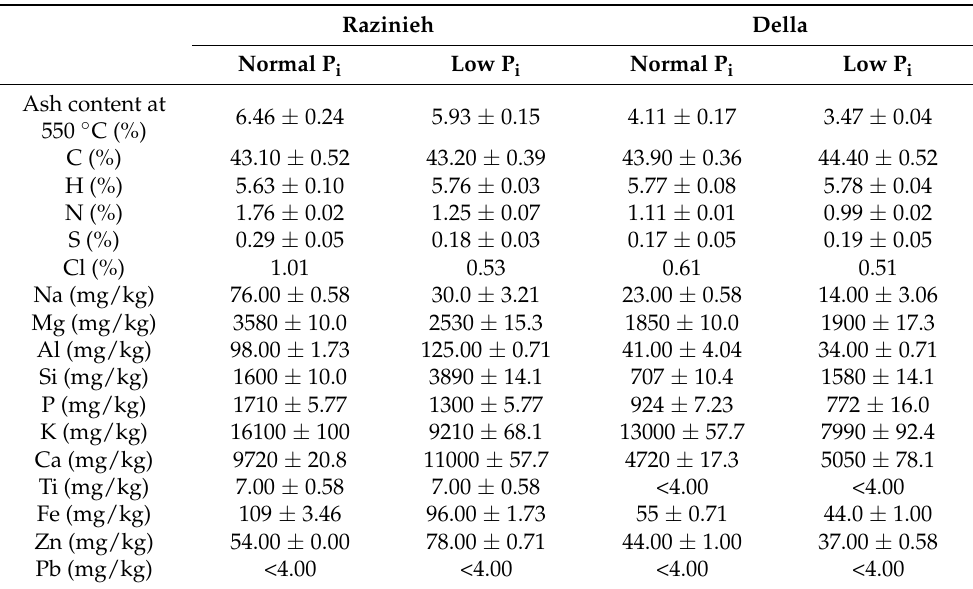
Table 1. Chemical composition of the straw of a grain (Razinieh) and a sweet (Della) sorghum variety grown under normal levels of P i or under P i starvation along with the abundance of residual ash generated from this straw by processing at 550 ◦